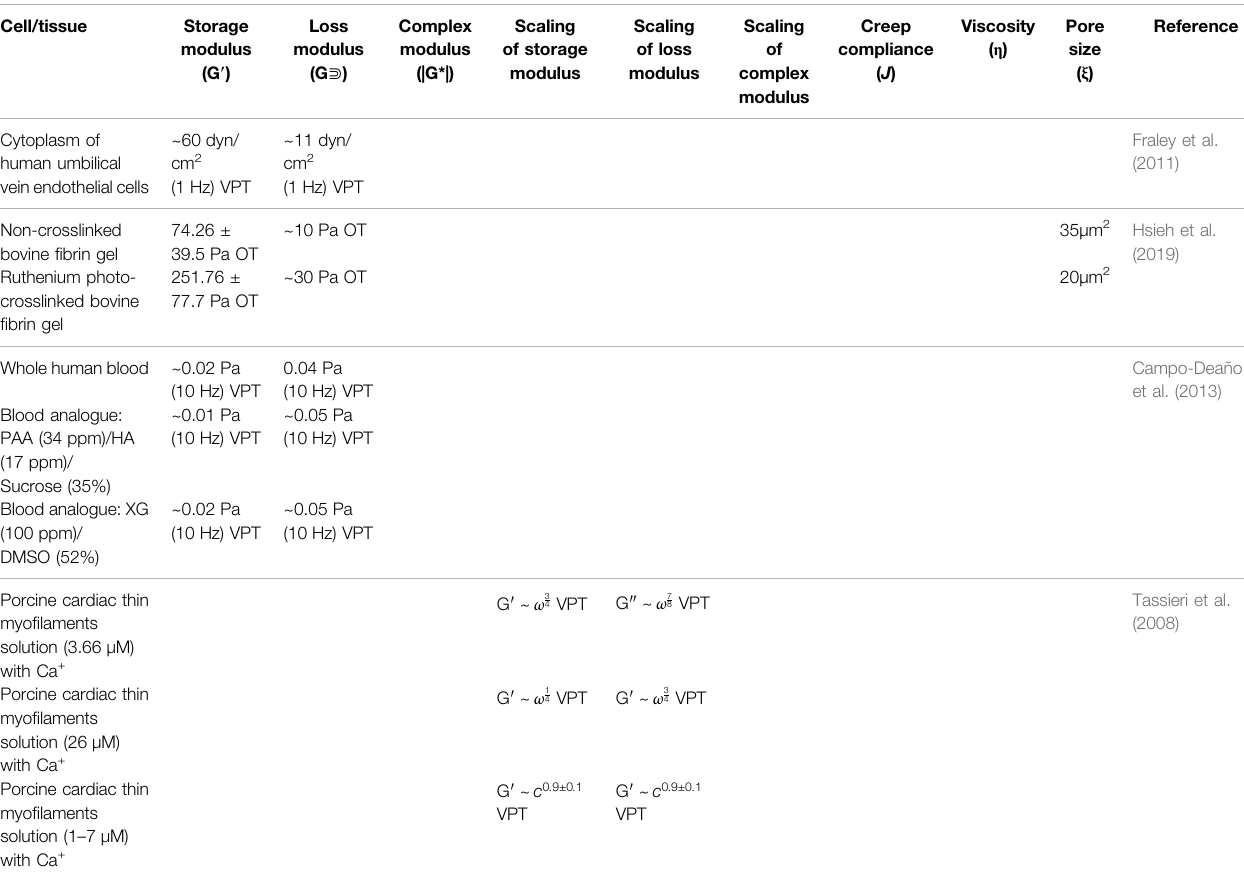
TABLE 5 | Microrheological properties of mammalian cells and tissue of the circulatory system measured by various microrheological techniques.